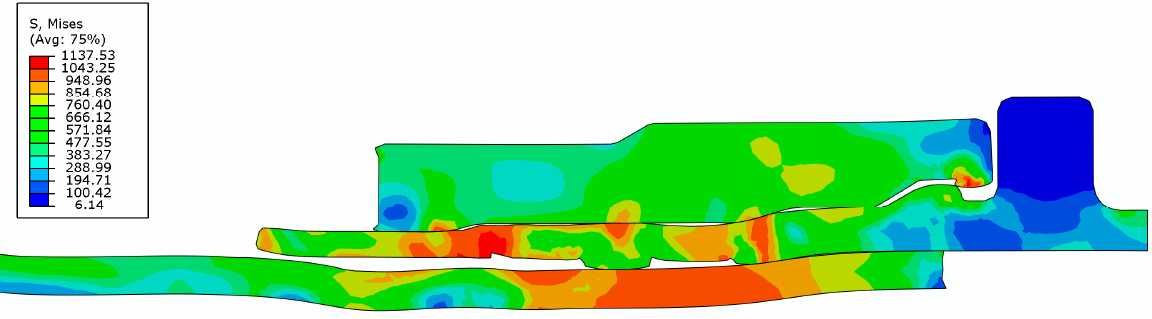
Figure 8. The von Mises stress distribution of axial extrusion joint after connection-strength experiment.